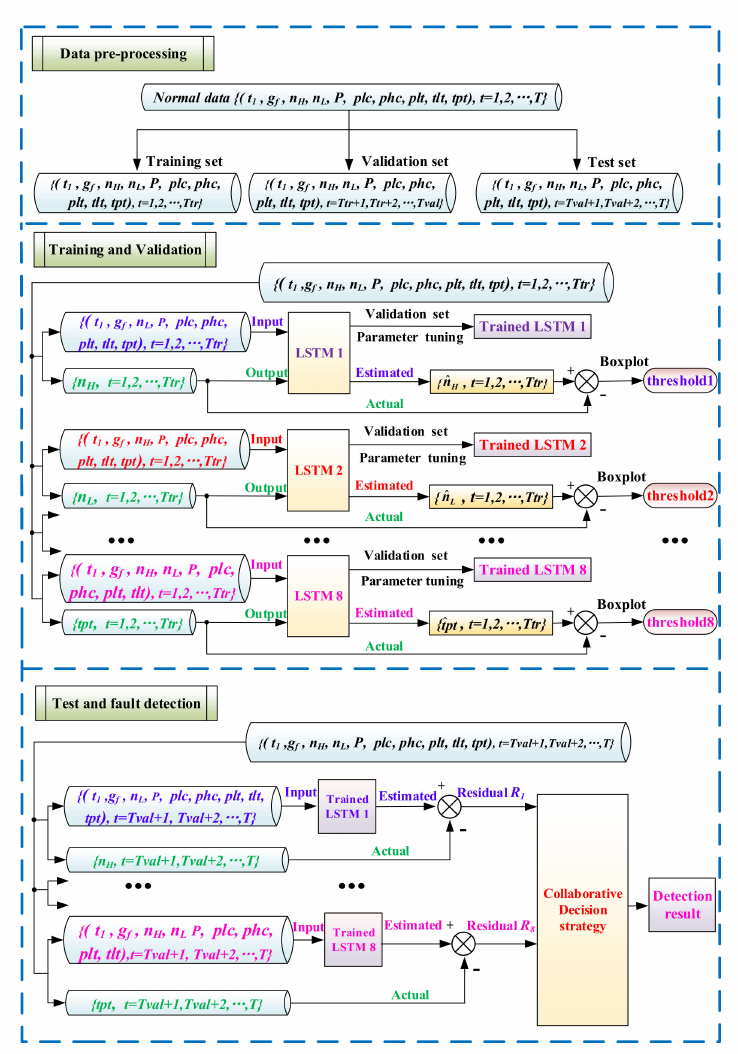
Figure 6. Technological process of this